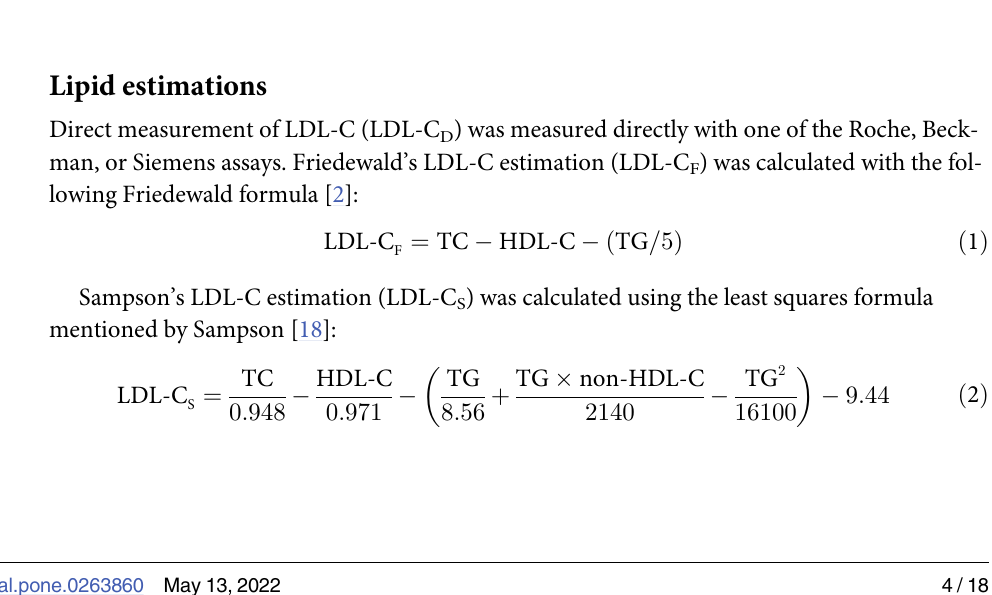
Values are expressed as N (%), mean ± SD or median(1 st —3 rd quartiles). TC: total cholesterol; TG: triglycerides; HDL-C: high-density lipoprotein cholesterol; LDL-C: low-density lipoprotein cholesterol; Non-HDL-C: non-high-density lipoprotein cholesterol; LDL-C D : LDL-C measured by direct assay; LDL-C F : LDL-C calculated by Friedewald formula; LDL-C S : LDL-C calculated by Sampson formula; LDL-C M : LDL-C calculated by Martin-Hopkins formula; LDL-C E : LDL-C calculated by the extended Martin-Hopkins